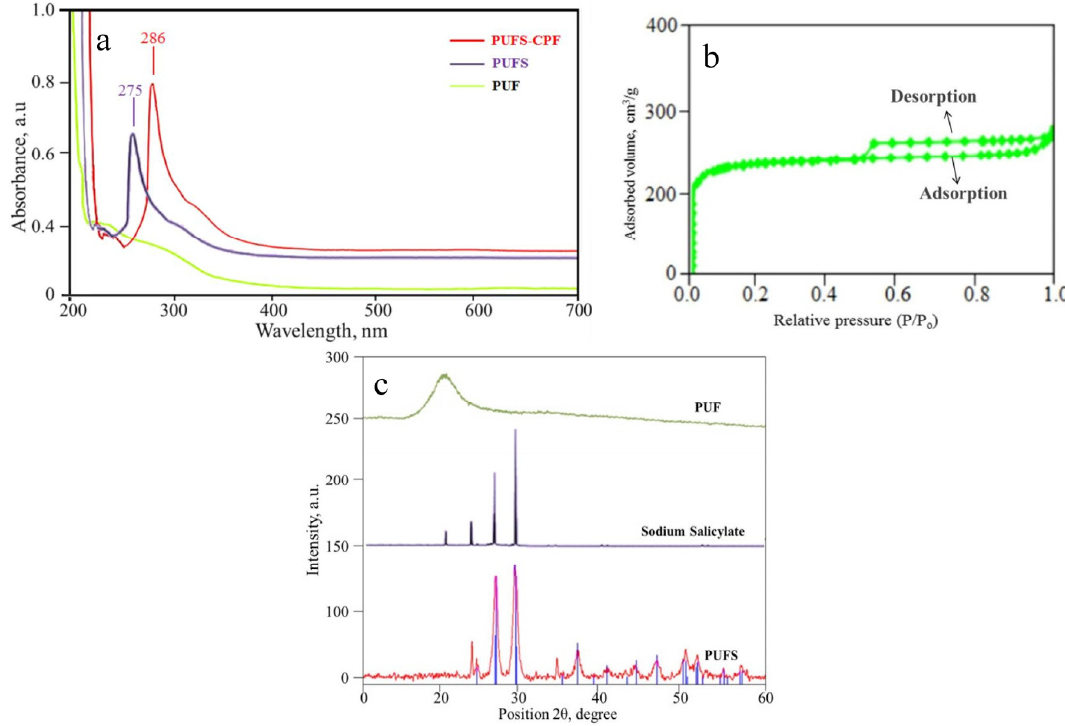
Figure 1. ( a ) UV–Vis absorbance spectra of white PUFSalicylate (PUF), PUFS and PUFS–CPF; ( b ) N 2 adsorption–desorption isotherms for PUFS, and ( c ) XRD spectra of white PUF, sodium salicylate and